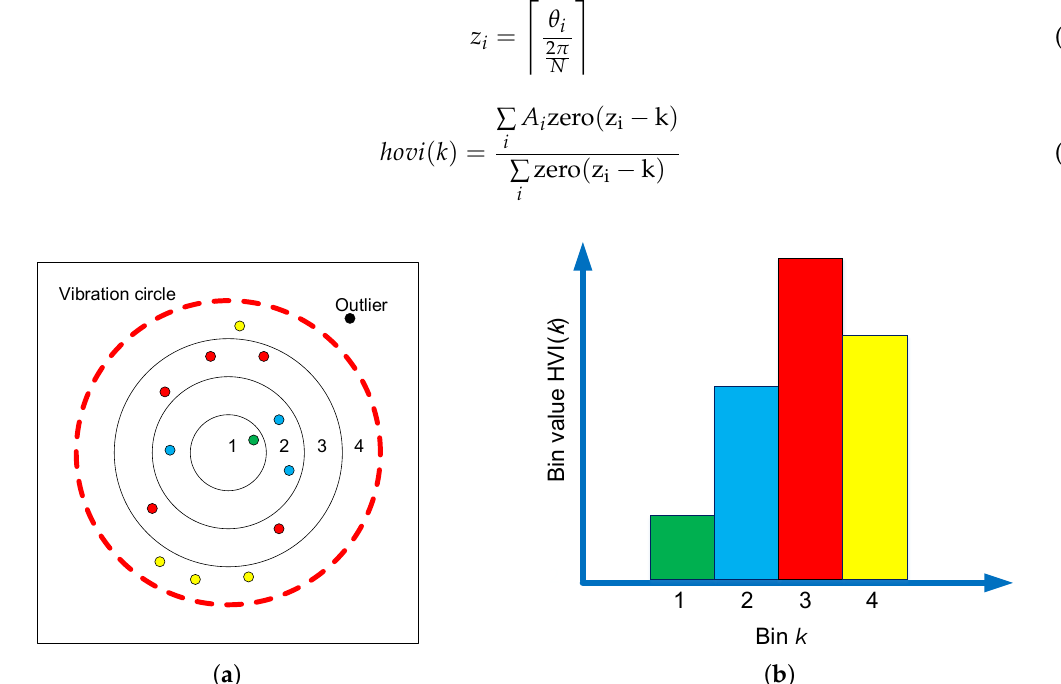
Figure 5. The schematic of HVI: ( a ) distribution of vibration points; and ( b ) histogram of vibration points.